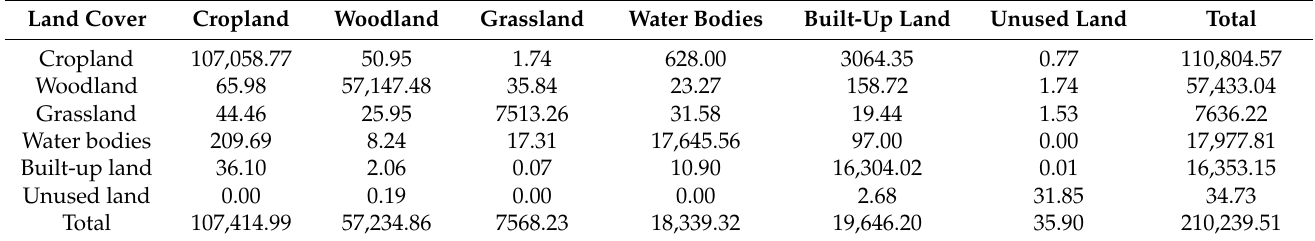
Table 4. Land conversion in Yangtze River Delta Region (2000–2005) (area: km 2 ).